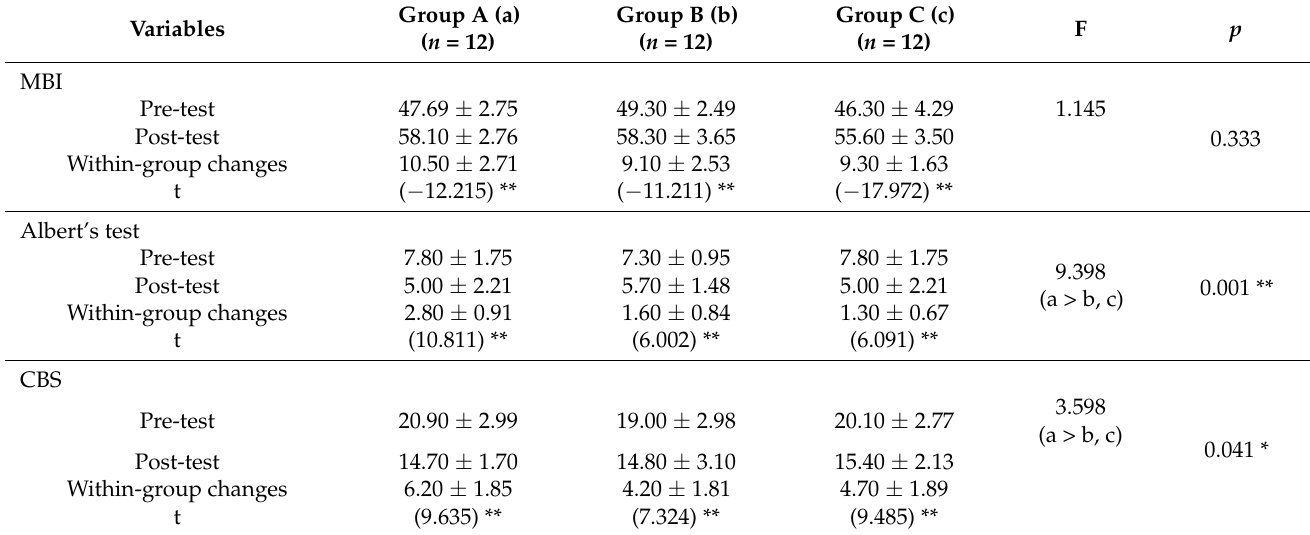
Table 2. Intergroup comparison from before to after the